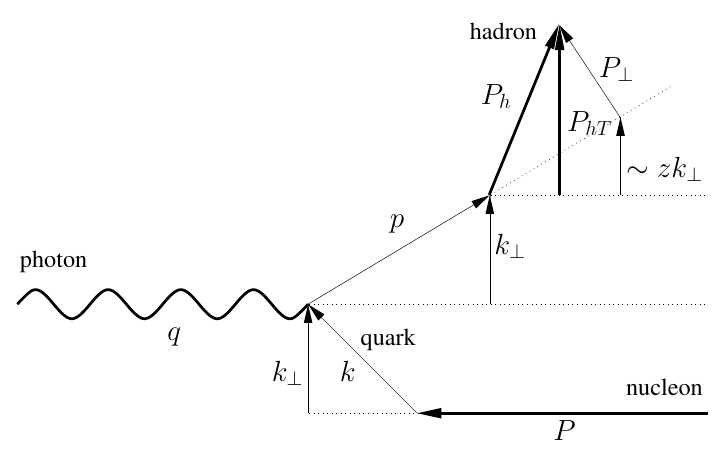
Figure 2 . Diagram describing the relevant momenta involved in a SIDIS event in the Breit (nucleon- photon) frame. A virtual photon with momentum q (defining the reference axis) strikes a parton with momentum k inside a nucleon with momentum P . The parton has a transverse momentum k ⊥ (not measured). The struck parton with momentum p = k + q fragments into a hadron with momentum P , which acquires a further transverse momentum P (not measured) with respect h ⊥ to the fragmenting quark axis. The total measured transverse-momentum of the final hadron is P hT . When Q 2 is very large, the longitudinal components are all much larger than the transverse components. In this regime, P + P hT ≈ z k ⊥ ⊥